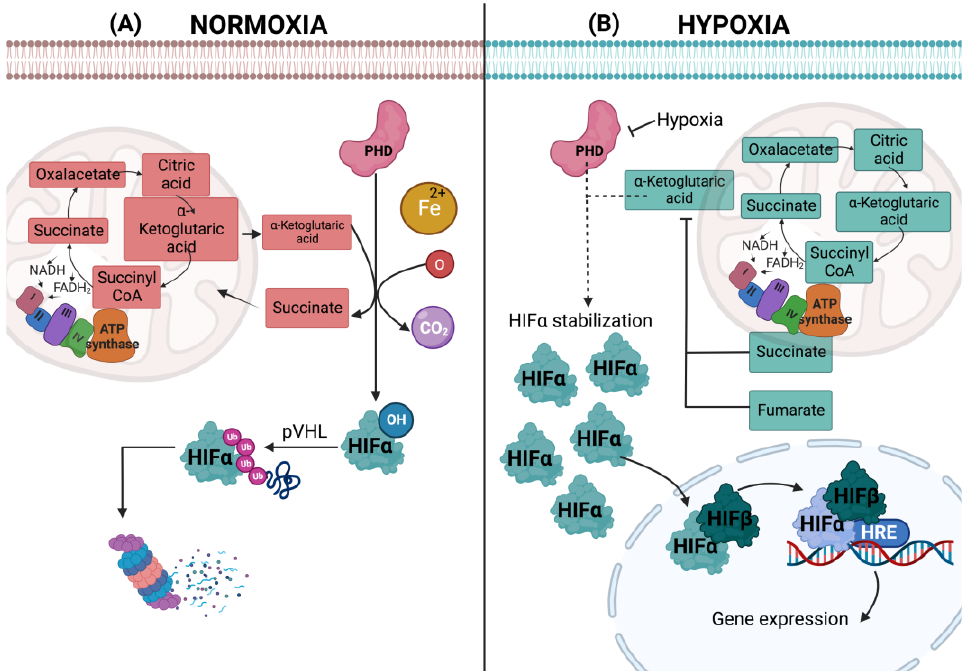
Figure 2. Hypoxia response mediated by HIFs. In normoxia, the hydroxylation of HIF- occurs in the cytosol, where PDH catalyzes the oxidative decarboxylation of α -ketoglutarate, obtaining carbon dioxide (CO2) and succinate once HIF- is hydroxylated and polyubiquitinated, a reaction catalyzed by pVHL. Finally, HIF- is degraded by the proteasome in the cytosol ( A ). In hypoxia, instead of being degraded by the proteasome, HIF- stabilizes in the cytosol and translocates to the nucleus. It heterodimerizes with HIF- 1β, and both subunits bind to HER, allowing it to recruit transcriptional coactivators to activate the transcription of hypoxia response genes ( B ).